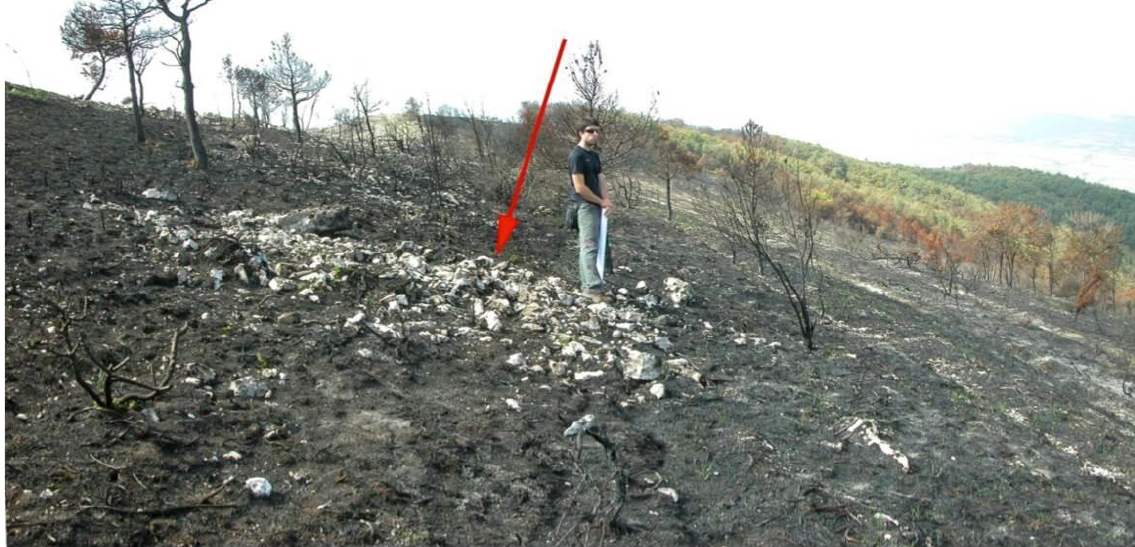
Figure 9. A view of a linear dump on the northern mountainside of “Sierra de